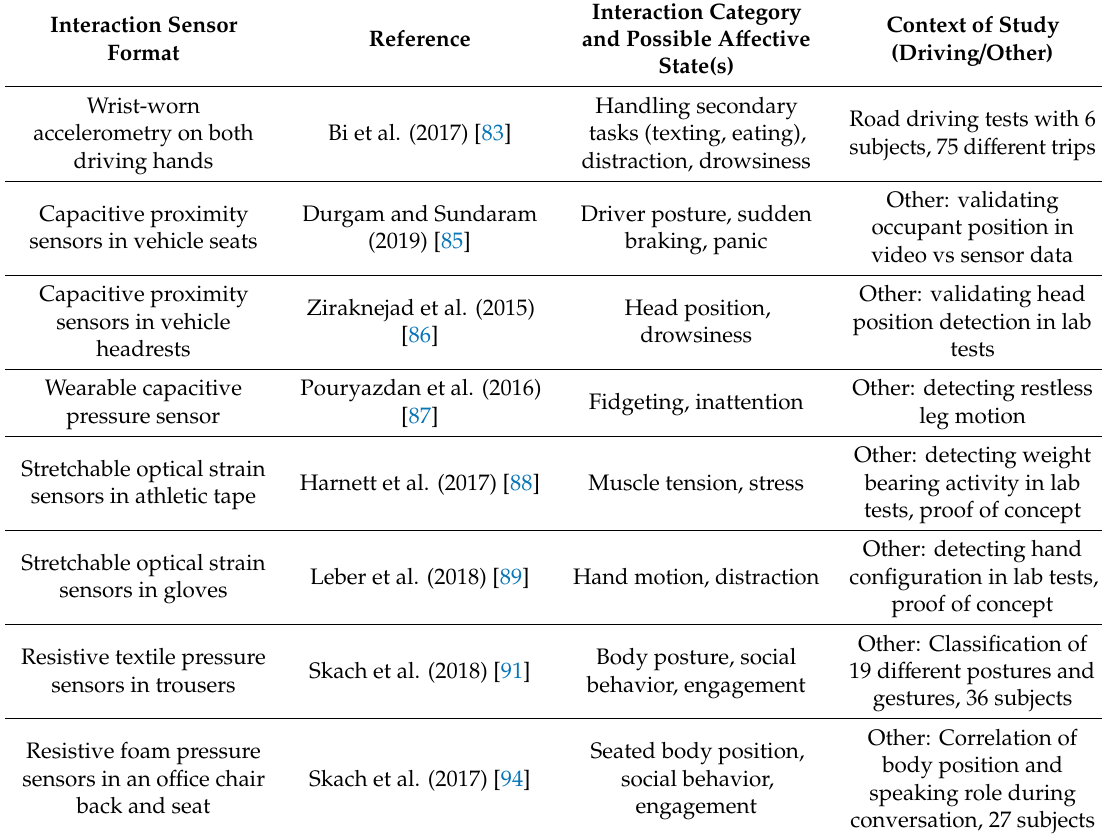
Table 3. Emerging sensor technologies that can capture driving-relevant user interaction